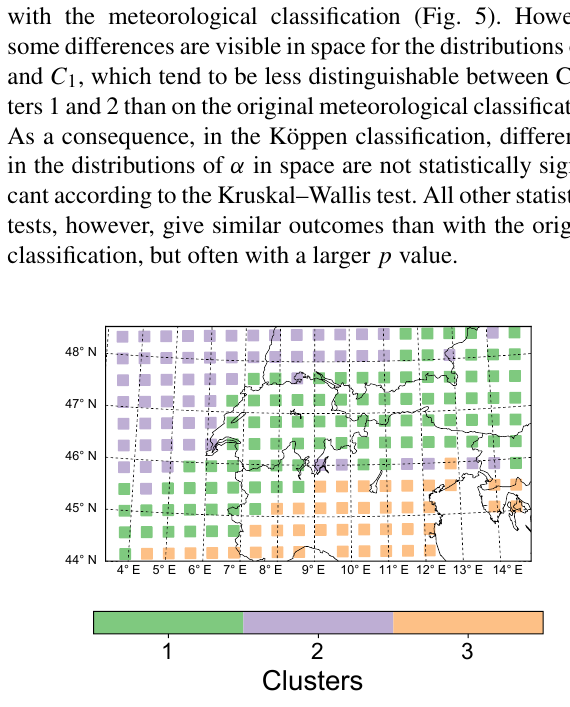
Figure C1. Aggregated Köppen climate classification within all 209 subsquares used in Sect. 4.2. Cluster 1 corresponds to Köppen classes Dwa, Dwb and Dfc (Cold climates), Cluster 2 to Köppen class Cfb (temperate with warm summer) and Cluster 3 to Köppen classes Cfa and Csa (temperate with hot